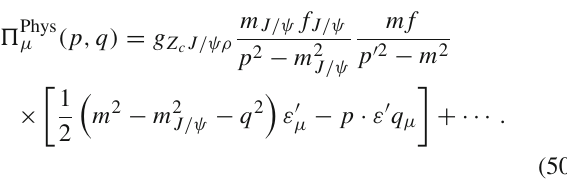
Thewidthofthedecay Z c → D 0 D − iscalculatedemploying the